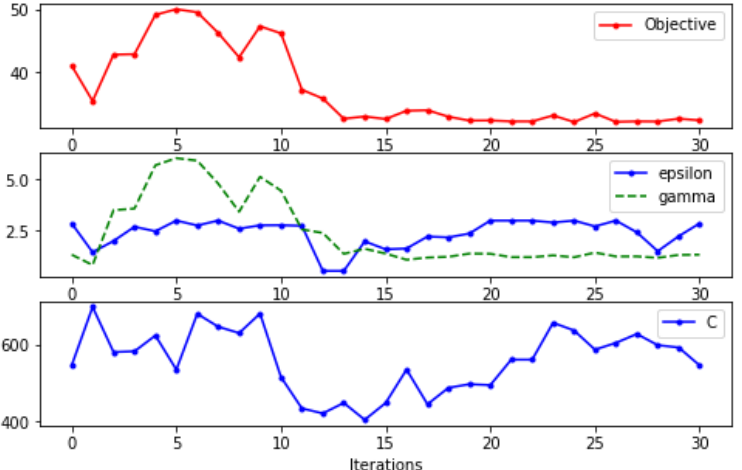
Figure 4. SVM parameters' optimization during the SA process.